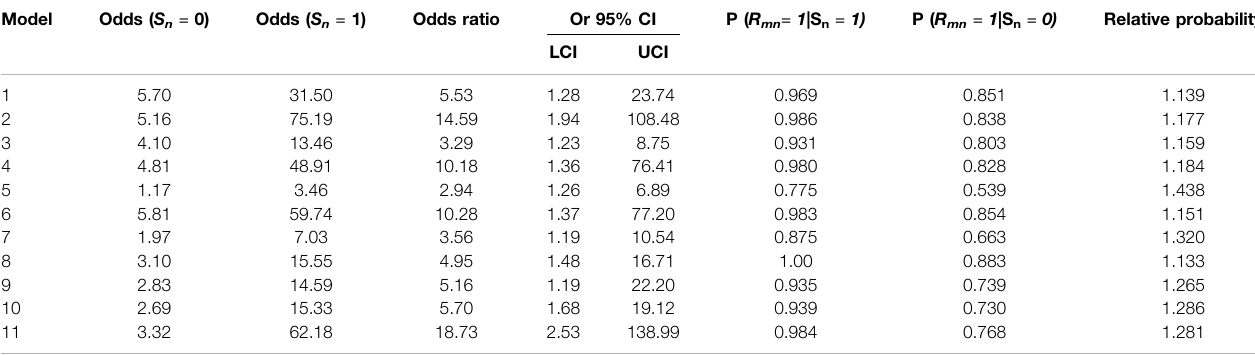
TABLE 6 | Fitted model odds ratios with con fi dence intervals and predicted probabilities. Model